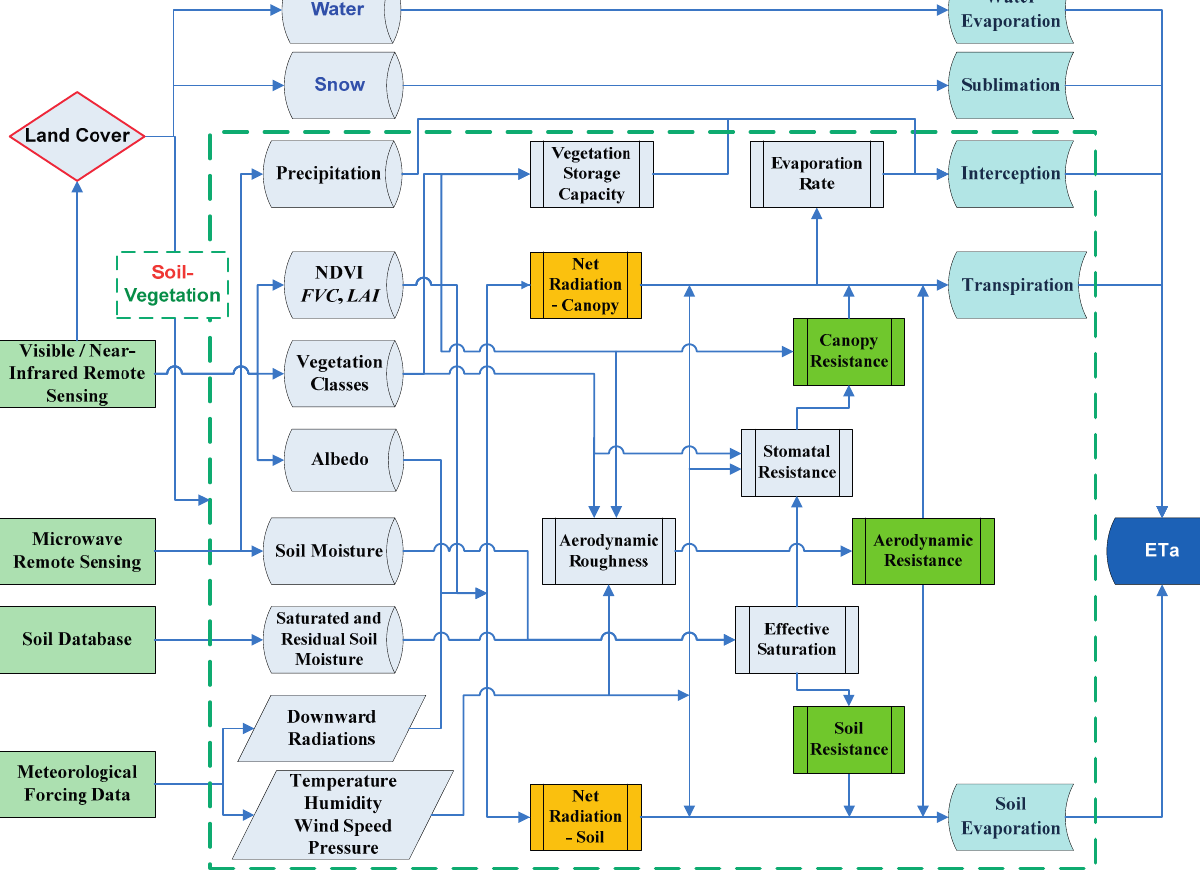
Figure 2. Flowchart of the ETMonitor model combining different evapotranspiration (ETa)